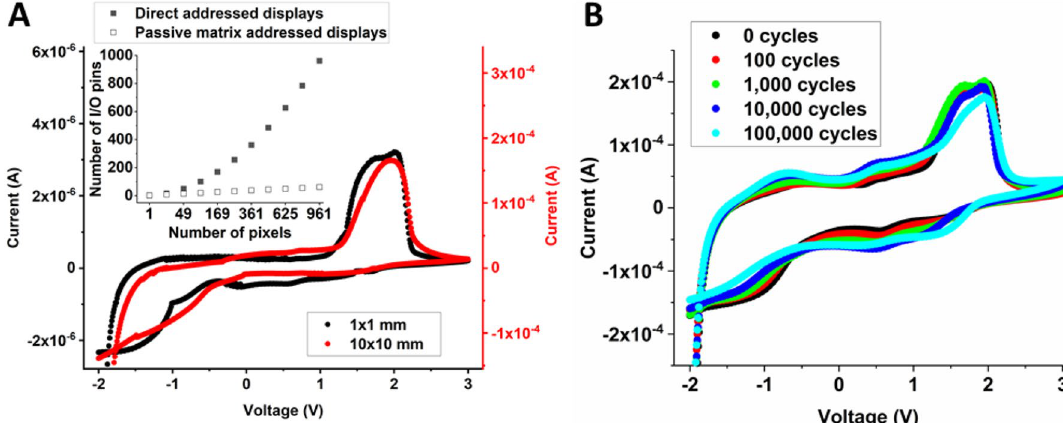
Figure 1. Non-linear pixel switching response obtained for various pixel areas, independent of the number of switching cycles. ( A ) The current vs. voltage characteristics show almost identical threshold voltages for two different pixel areas; 1 × 1 and 10 × 10 mm. The inset shows the benefit of using the passive matrix addressing protocol as compared to direct addressing. The number of I/Os required from the addressing electronics scales linearly with the number of pixels in direct addressed displays (filled squares), while the number of I/Os required in PMADs equals the sum of the rows and columns (open squares). The number of pixels on the x-axis corresponds to square-shaped pixel arrangements (7 × 7, 13 × 13, 19 × 19, 25 × 25 and 31 × 31). ( B ) Current vs. voltage curves recorded after a certain number of switching cycles (represented by the different colors), ranging from the initial switching behavior up to 10 5 switching